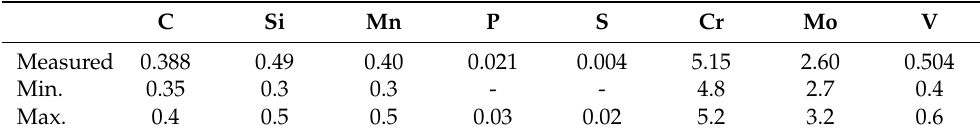
Table 1. Chemical composition of the specimen and chemical composition in accordance to DIN EN ISO 4957 in wt%, Fe-bal.